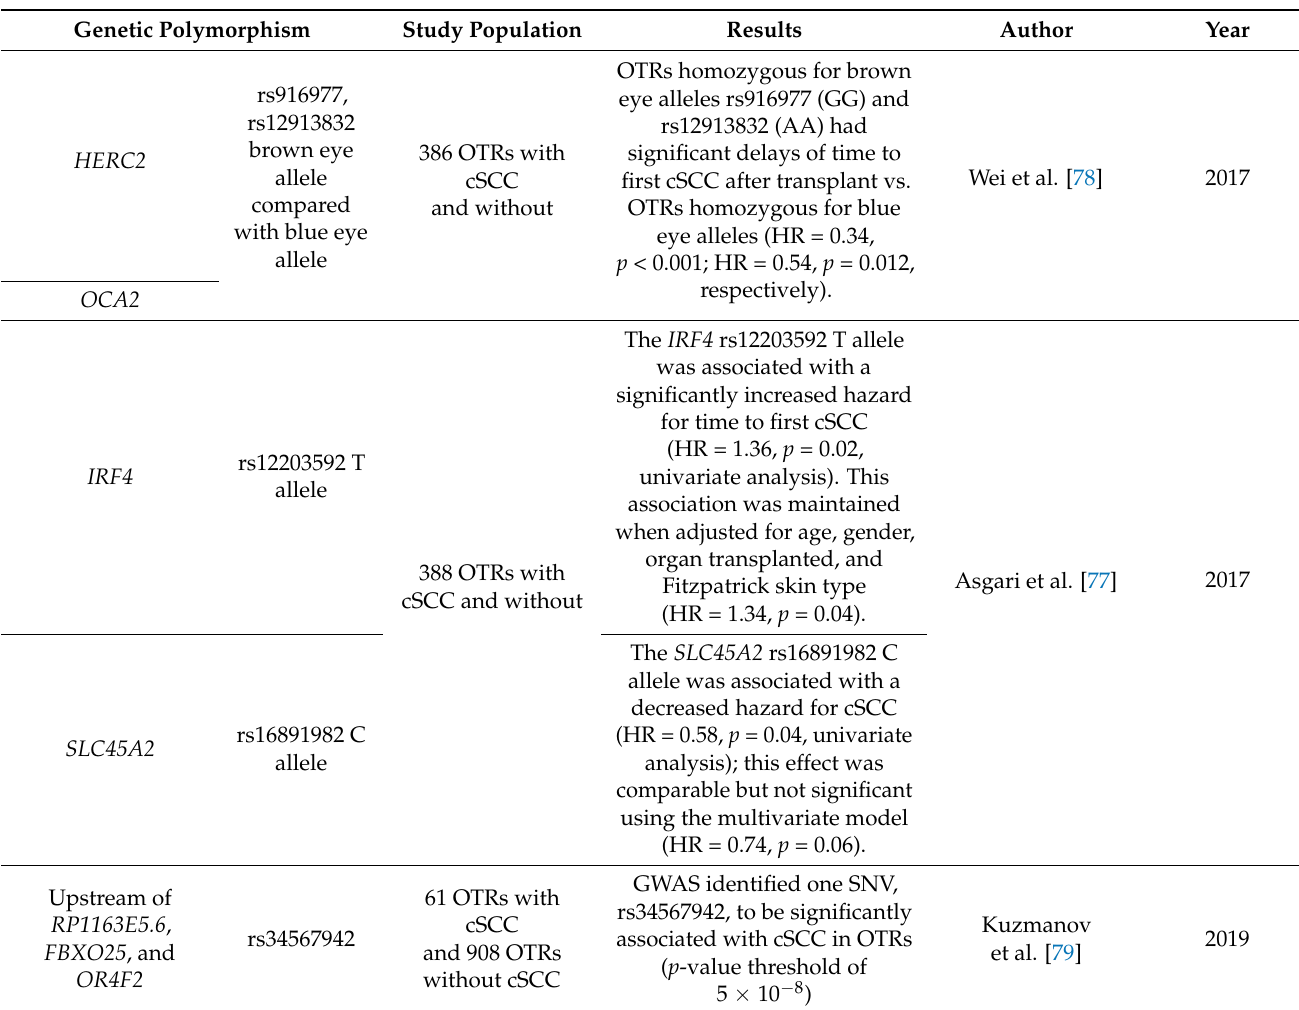
Table 8. Genetic polymorphisms associated with cSCC in the